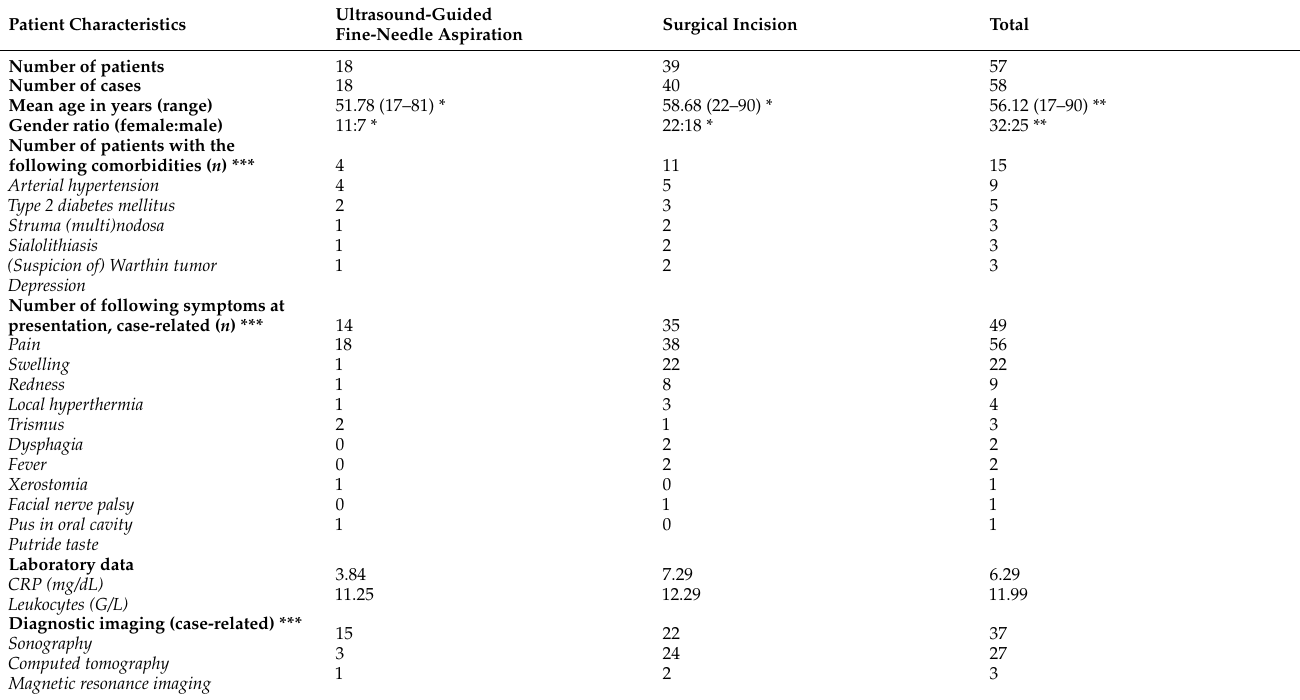
Table 1. Patient